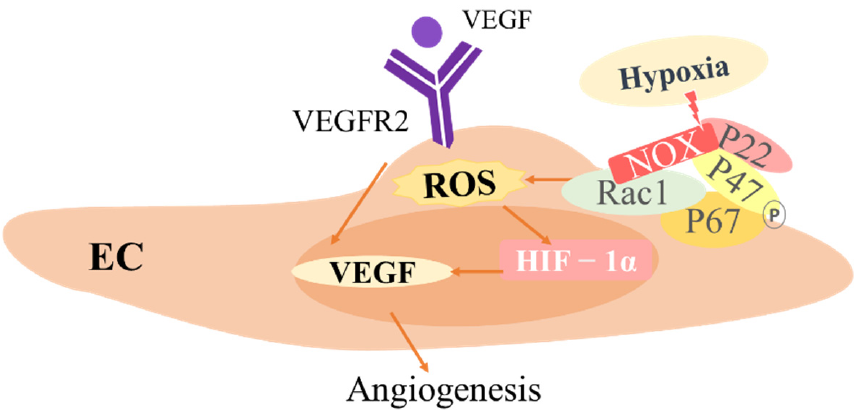
Figure 4. The role of ROS in endothelial cells (ECs). Vascular endothelial growth factor (VEGF) stimulates ROS production through RAC1-mediated activation of NOX, followed by the autophosphorylation of VEGFR2 and activation of downstream signaling pathways critical for endothelial cell migration and proliferation. In addition, hypoxia activates the transcription factor HIF-1 α by inducing ROS production, which in turn upregulates VEGF secretion and expression and promotes angi- ogenesis.